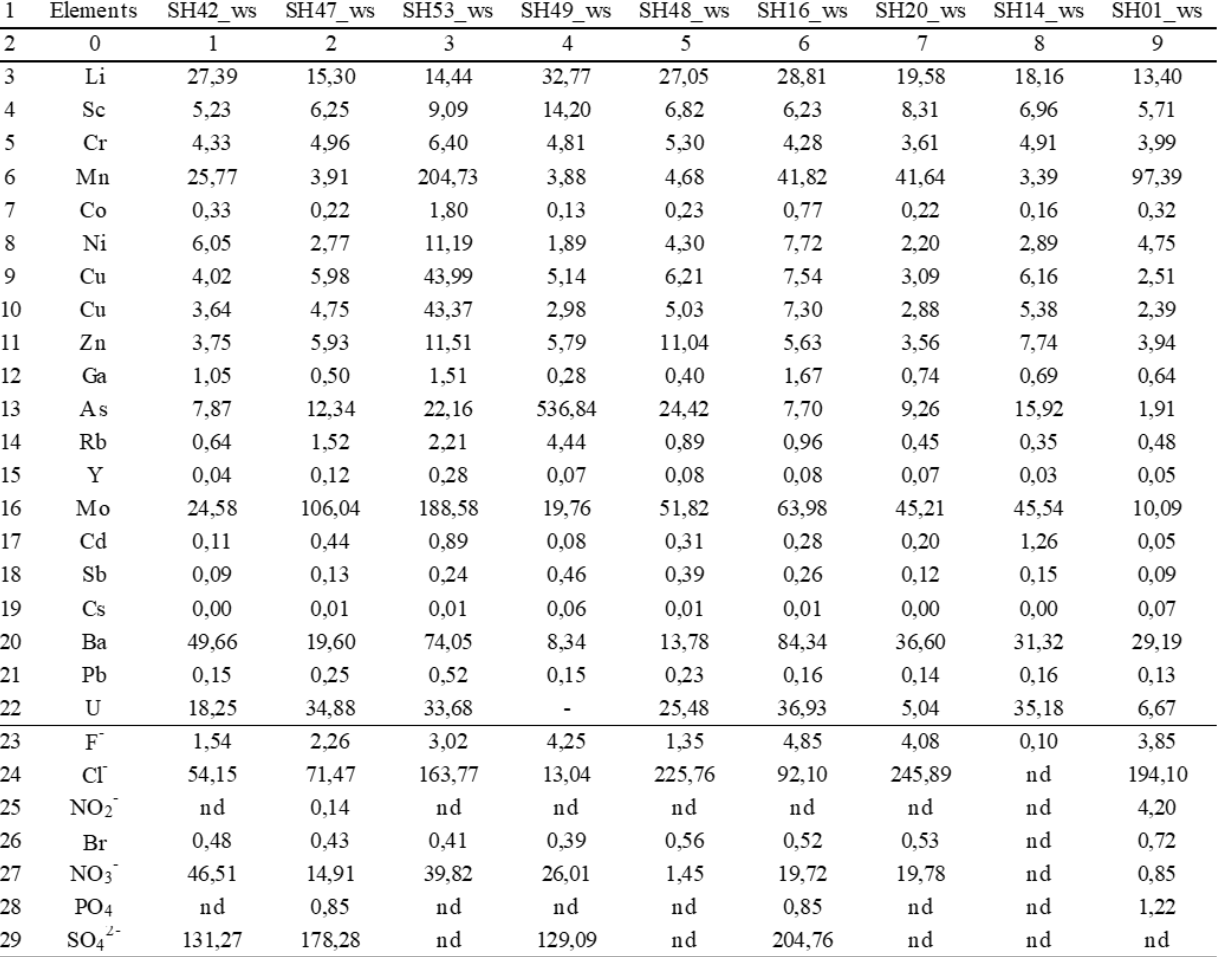
Table 3. Heavy metals (ug/L) and anion contents (ppm) of the water samples, Shuteen